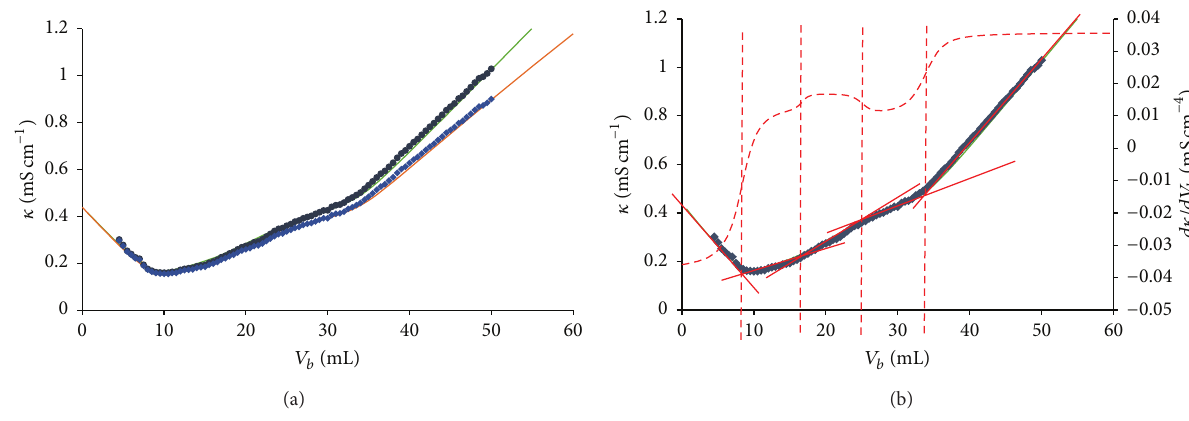
Figure 7: Plots of 𝜅 and 𝜅 corrected conductivity are different because of a large dilution during titration. (b) Plots 𝜅 through (23) and (3) (solid line) and its first derivative, 𝑑𝜅 emphasize the linear trends in the conductivity curve while the broken lines are ancillary elements to emphasize that the slope changes must coincide for both graphical representations: 𝜅